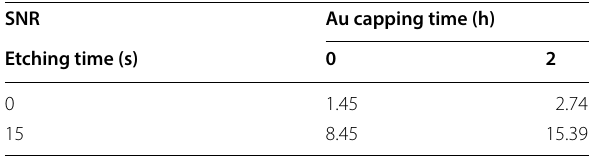
Table 1 SNR of the FO‑LSPR sensor for different